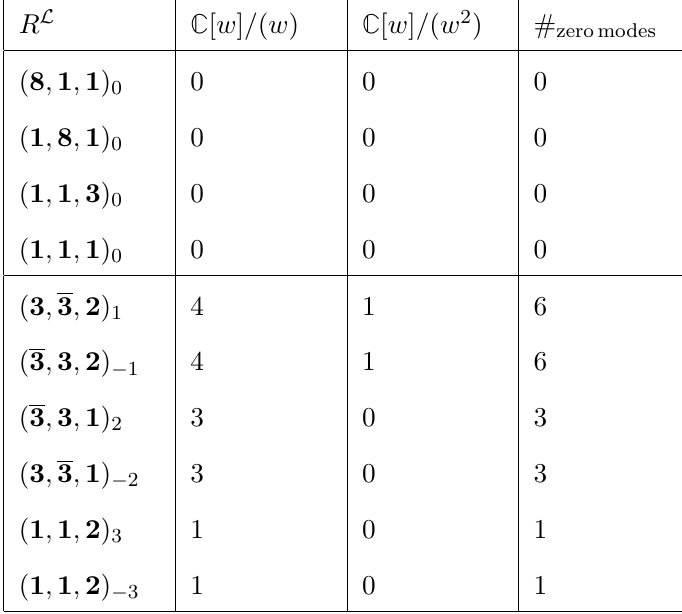
Table 1 . 5d modes for E 6 length three simple